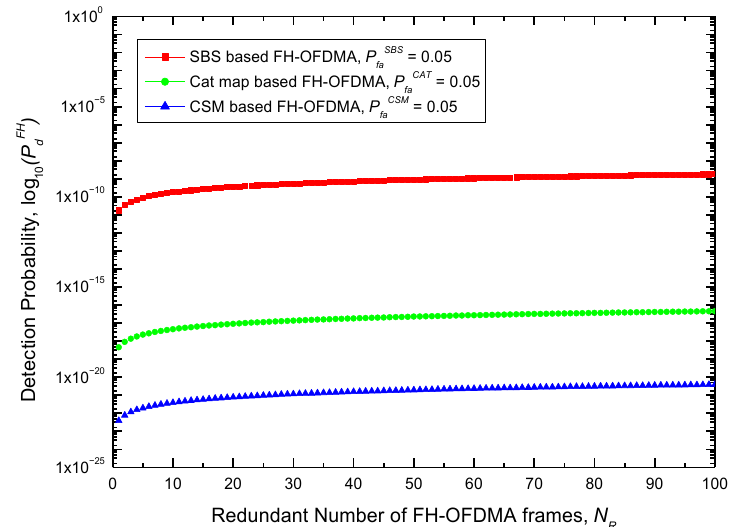
Figure 5. Detection probability versus redundant number of FH-OFDMA frames for detection compared to SBS, cat map, and CSM-based FH-OFDMA systems.